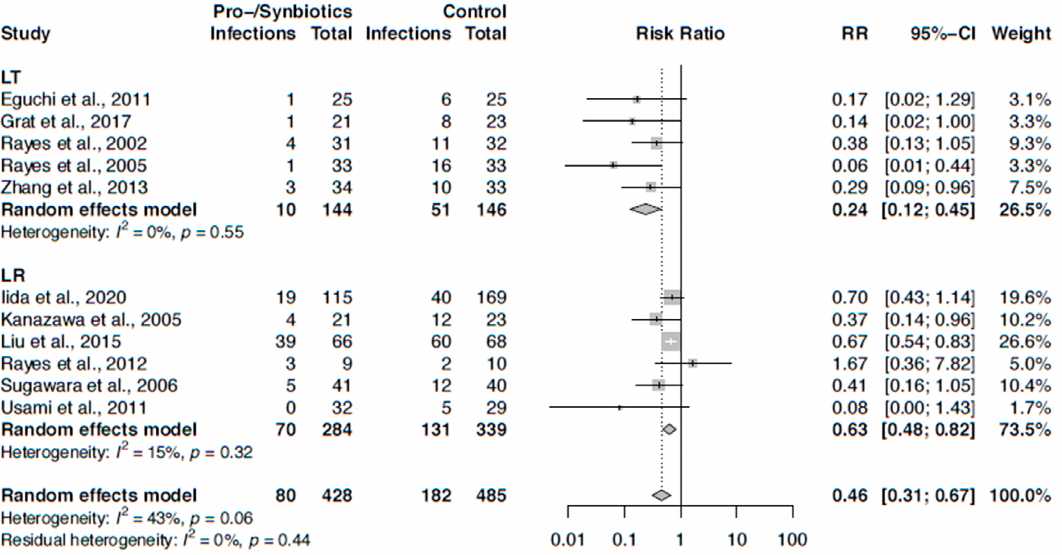
Figure 3. Forest plot of trials on perioperative pro- / synbiotics and their e ff ect on infection stratified by type of surgery: liver resection (LR), liver transplantation (LT). Pooling the results for infection rates from studies of both study designs in a meta-analysis, pro- / synbiotics showed a significant lower infection rate (RR 0.46, 95% CI: 0.31–0.67). However, there was moderate heterogeneity (I 2 = 43%, p = 0.06). When stratifying by LR or LT, both subgroups showed a benefit of pro- / synbiotics, but the e ff ect was stronger in LT patients than in LR patients (Figure 3). Furthermore, residual heterogeneity was insubstantial. We also performed a sensitivity Nutrients 2020 , 12 , x FOR PEER REVIEW analysis including only RCTs, where one study was excluded. The results were very similar (Figure 4).